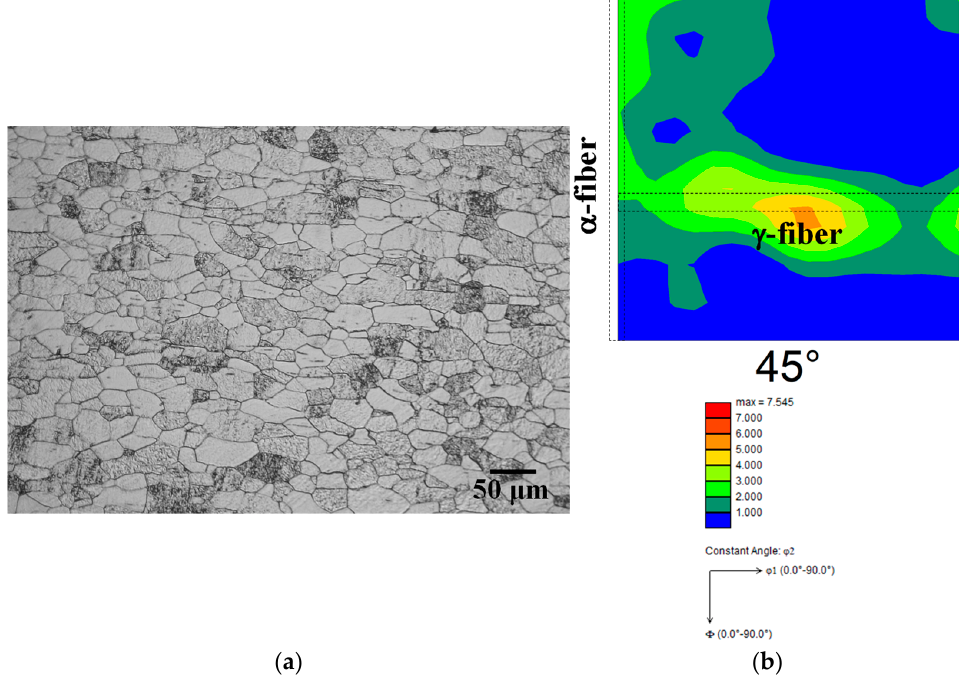
Figure 1. ( a ) Optical micrograph and ( b ) ODF map of as-received sheet.